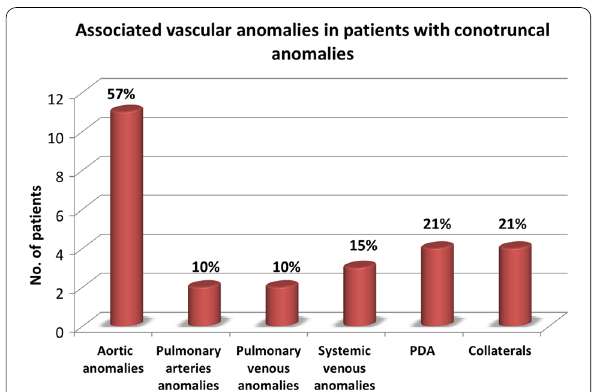
Fig. 3 Bar graph showing associated vascular anomalies in patients with conotruncal